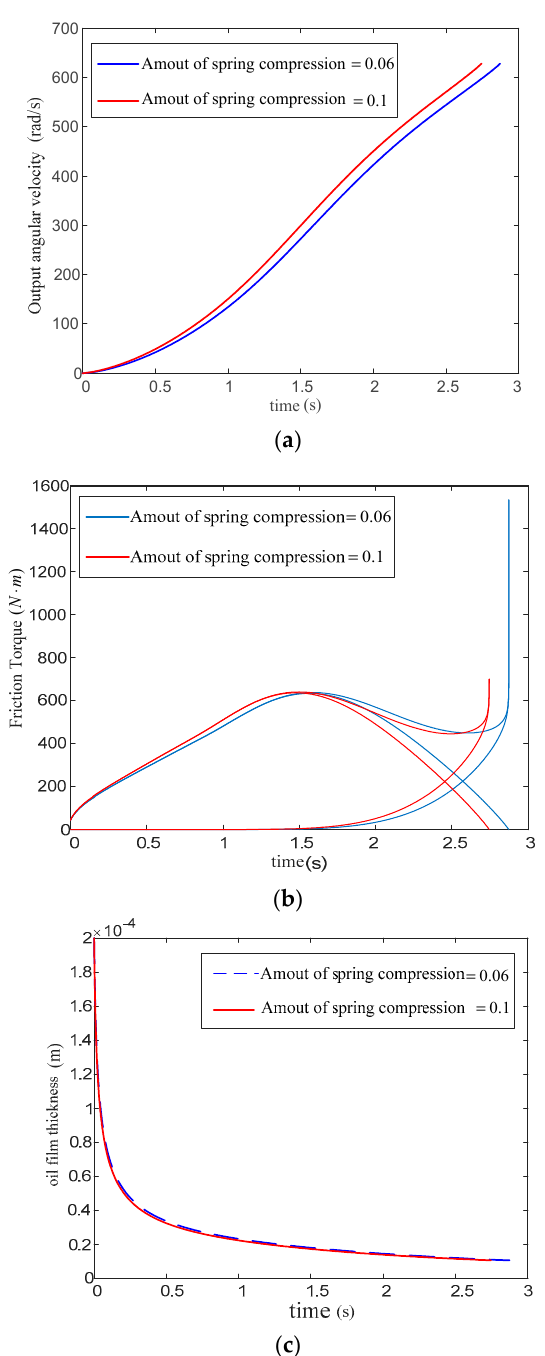
Figure 11. Effect of spring compression on output speed, friction torque, and film thickness. ( a ) Effect of spring compression on output speed; ( b ) Effect of spring compression on friction torque; ( c ) Effect of spring compression on output speed; ( b ) E ff ect of spring compression on friction torque; ( c ) E ff ect of of spring compression on oil film thickness. spring compression on oil film